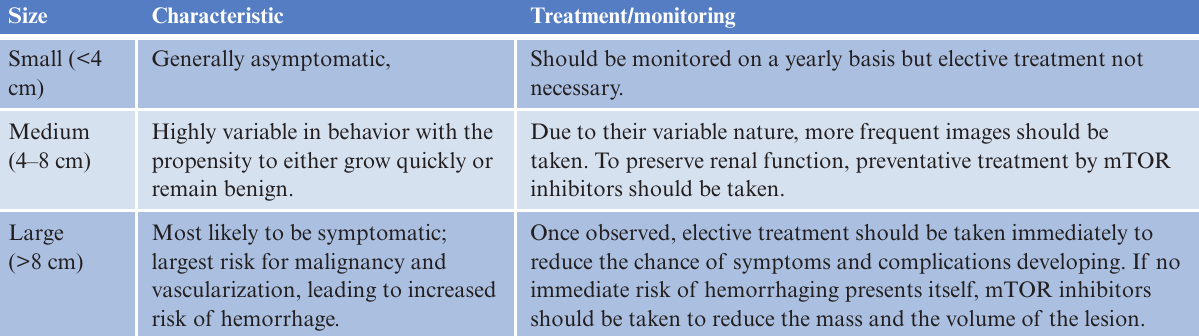
Table 4: Diagnosis and treatment of